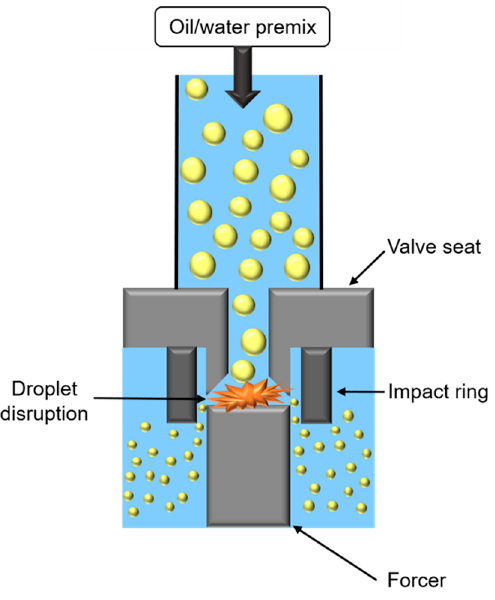
Figure 6. Schematic representation of high ‐ pressure homogenizer.